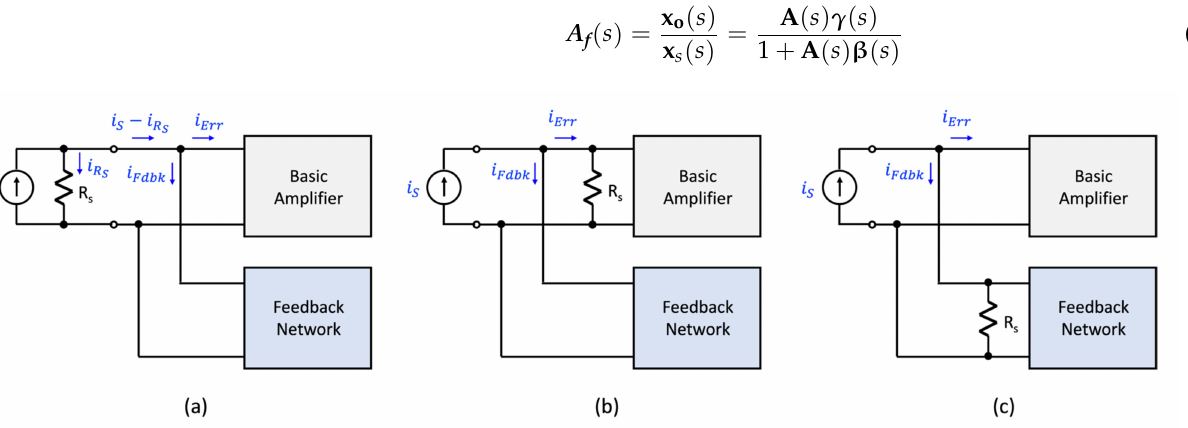
Figure 5. Three equivalent current-mixing arrangements; two are compliant with Black’s single-loop feedback structure: ( a ) noncompliant, ( b ) compliant option 1, and ( c ) compliant option 2.